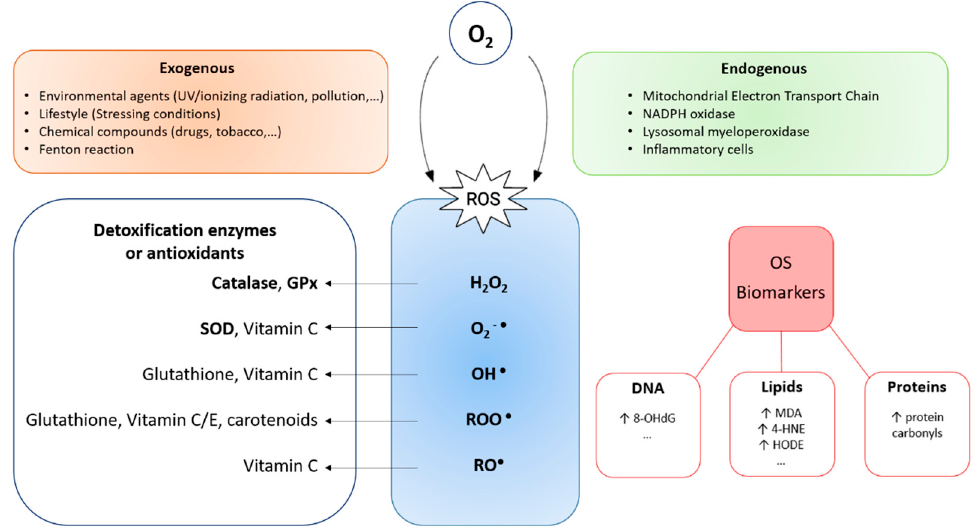
Figure 1. Diagram representing reactive oxygen species (ROS) production, their detoxification mechanisms and the oxidative stress alterations produced by their action, which can serve as oxidative stress (OS) biomarkers. Abbreviations: NADPH, nicotinamide adenine dinucleotide phosphate; GPx, glutathione peroxidase; SOD, superoxide dismutase; H 2 O 2 , hydrogen peroxide; O 2 − • , superoxide anion radical; OH • , hydroxyl radical; ROO • , p eroxyl radical; RO • , alcoxyl radical; 8- OHdG, 8-hydroxy-2 ′ -deoxyguanosine; MDA, malondialdehyde; 4-HNE, 4-hydroxynonenal; HODE, hydroxyoctadecadienoic acid.